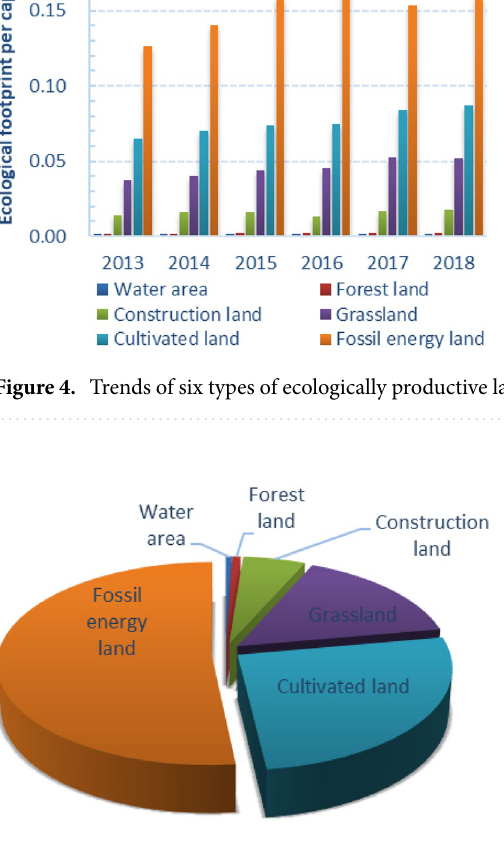
Figure 5. Share of different types of land in total ecological